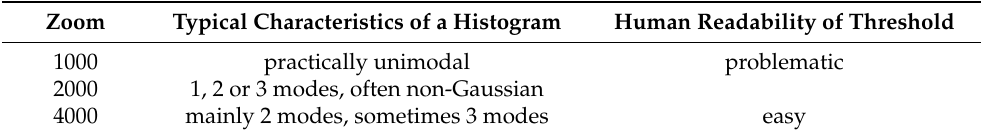
Table 11. Characteristics of the BG/LD histograms (block 4, Figure 7) for the individual zoom levels. Zoom Typical Characteristics of a Histogram Human Readability of Threshold 1000 practically unimodal 4000 mainly 2 modes, sometimes 3 modes